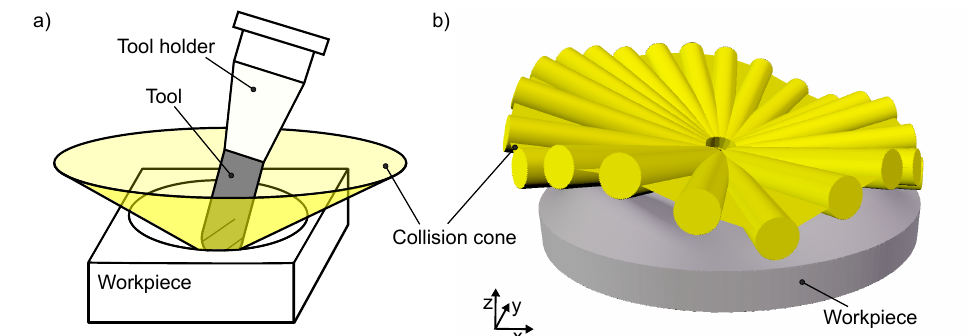
Figure 7. Principle of the collision avoidance between workpiece, toolholder and tool, cf. [4], showing ( a ) the calculated collison cone, with collision-free rotations. In ( b ) the tilted cylinders within the simulation are shown, marking the maximal collision-free angles.